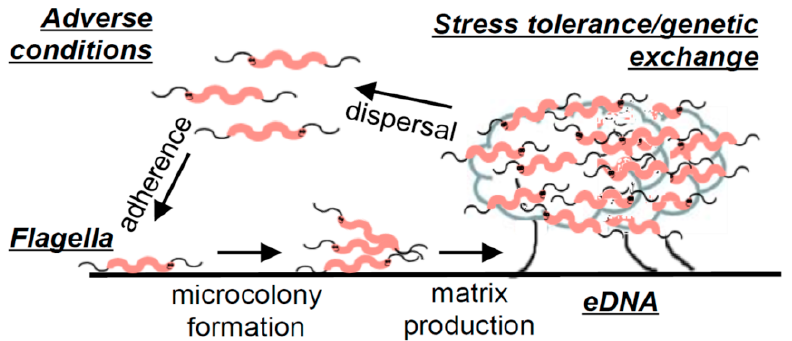
Figure 3. Illustration of C. jejuni biofilm formation. Figure taken from “Flagella mediated adhesion and extracellular DNA release contribute to biofilm formation and stress tolerance of Campylobacter jejuni ” by Svennson et al. [14] (reprinted under an open access license).